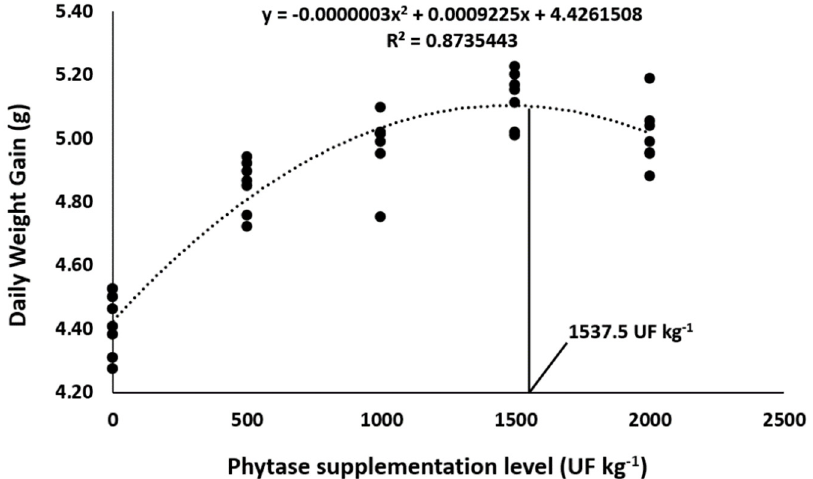
Figure 1. Daily weight gain of Nile tilapia fed diets supplemented with graded levels of phytase. The black points represent the seven replicates of each dietary treatment. Lines were used to mark the optimum supplementation level of phytase determined by the quadratic regression.